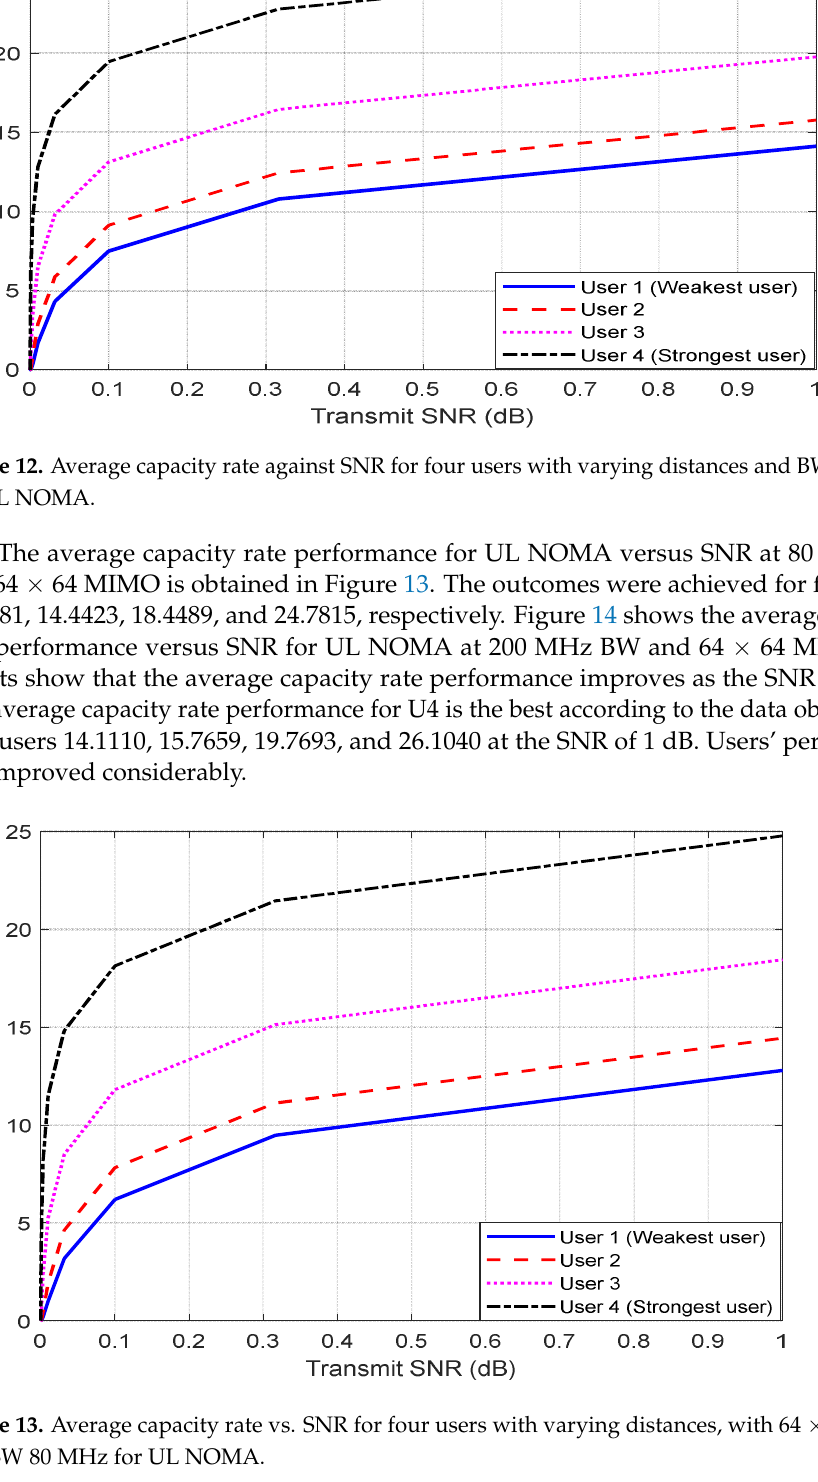
Figure 11. Average capacity rate vs. SNR for four users with varying distances and BW 80 MHz for UL NOMA.